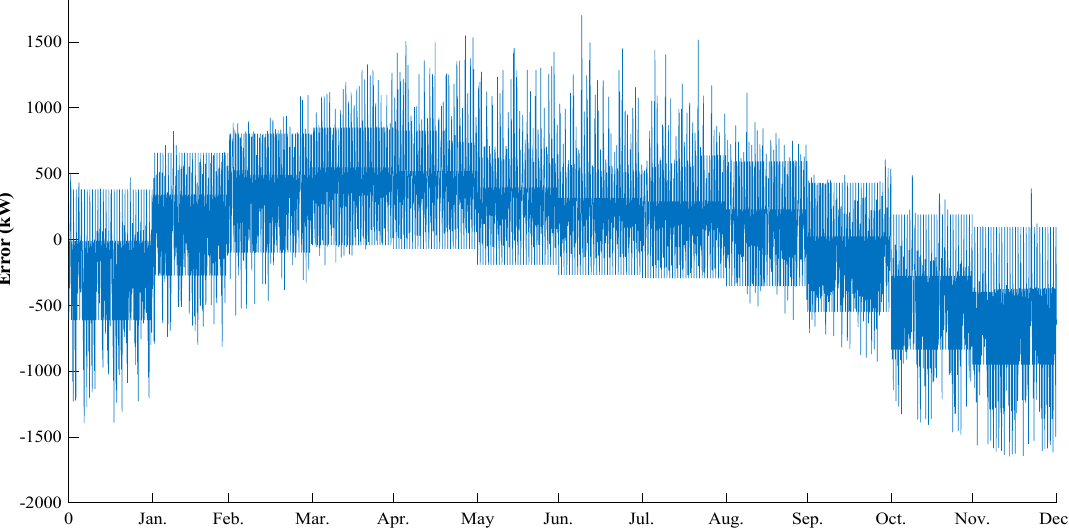
Figure 12. Annual PV power output error with PSO-ANN forecasting.